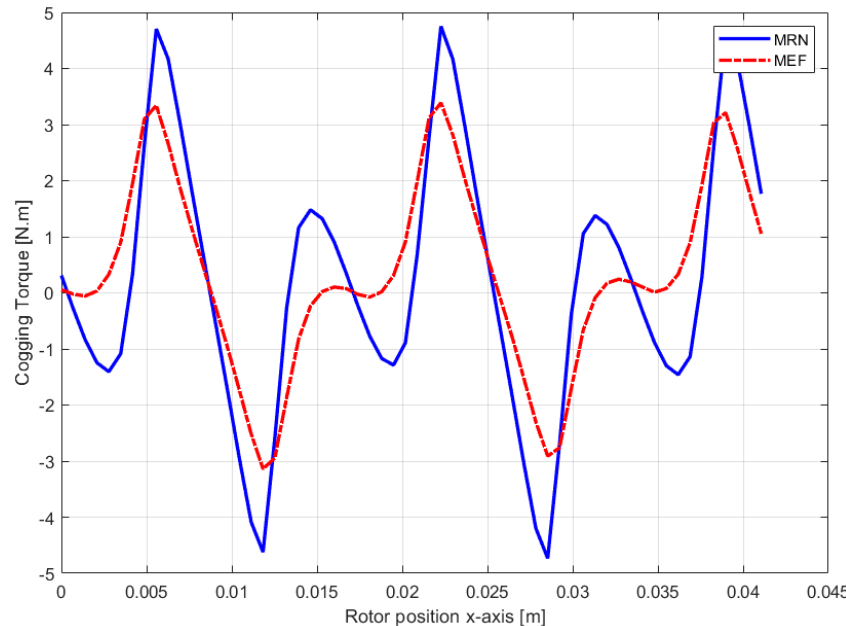
Figure 16. Comparison between the cogging torque results generated by the 2D RN and 2D FEM models.